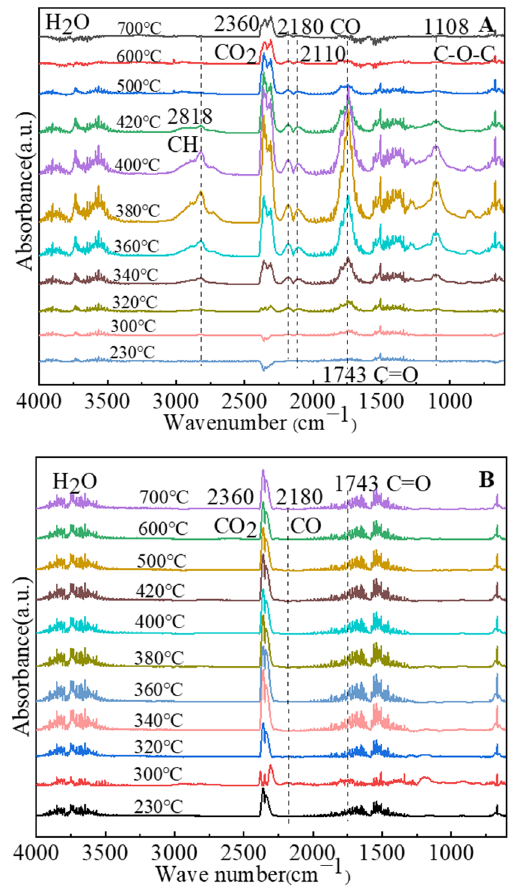
Figure 8. TG-IR spectrum of fabrics: ( A ) original fabric; ( B ) finished fabric.